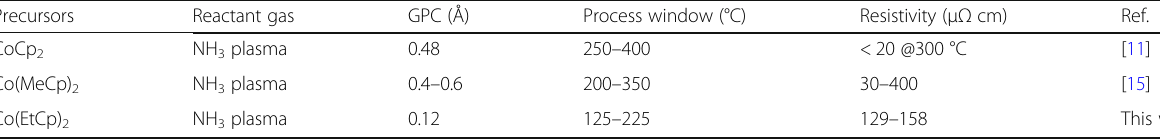
Table 3 The performance comparison of the Co films grown by different precursors